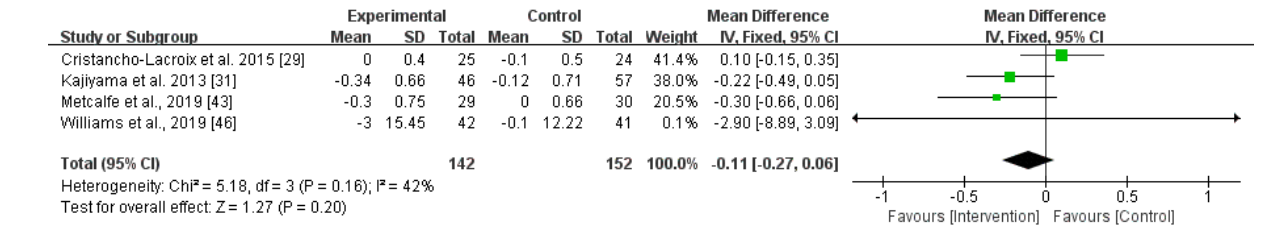
Figure 7. The effect of internet-based supportive interventions on caregiver reaction to behavioral symptoms.